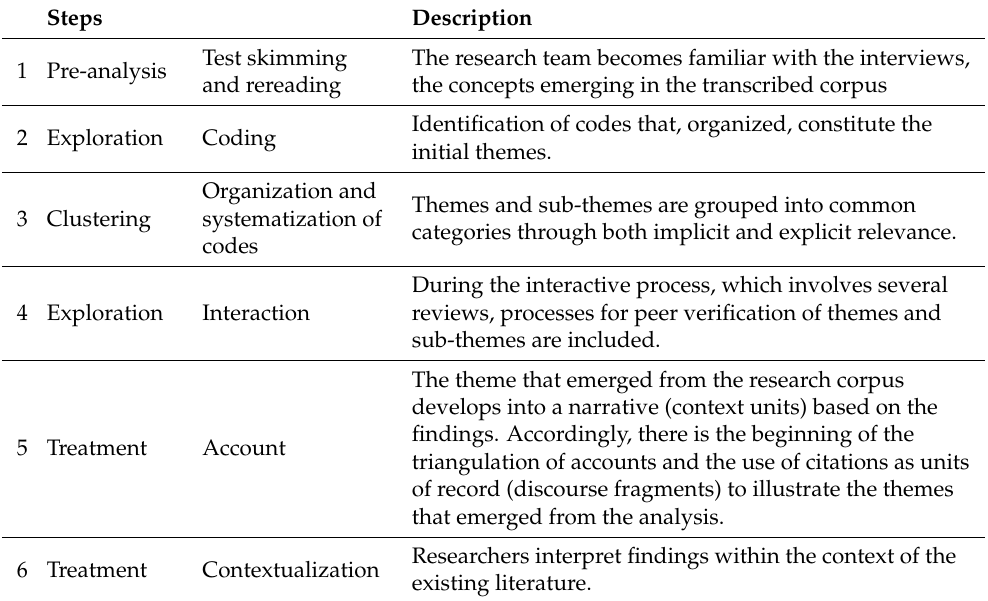
Table 3. Six steps of the analysis. Brazil,